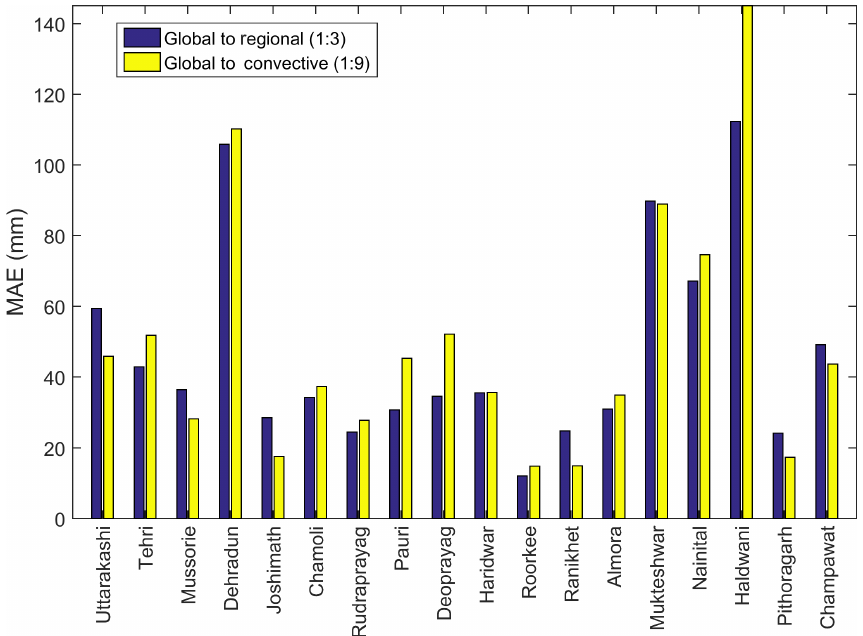
Figure D1. Bar plot representing the mean absolute errors in simulating rainfall across the 18 rain gauge locations on global to regional (G2R) scale (1:3) and global to convection-permitting (G2C) scale